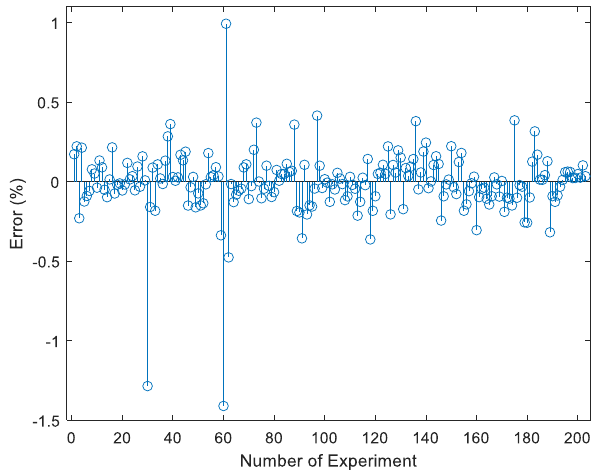
Figure 8. Experimental data error value for µ nf .